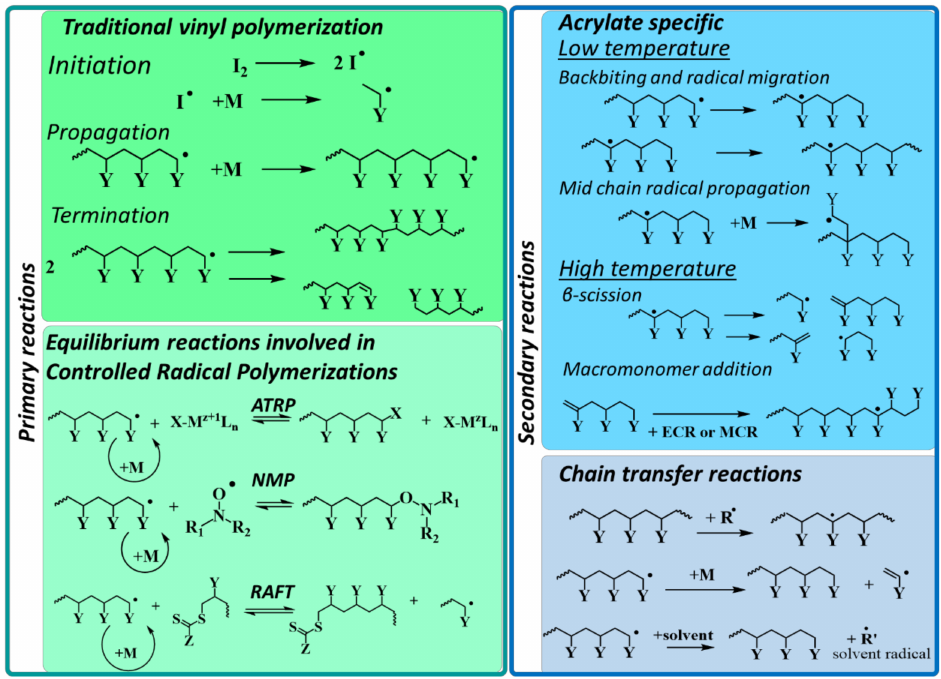
Figure 4. Primary and secondary reactions in free radical polymerization (FRP); specific focus is on the FRP of acrylates; also included are the extra reactions if one goes from FRP to controlled radical polymerization